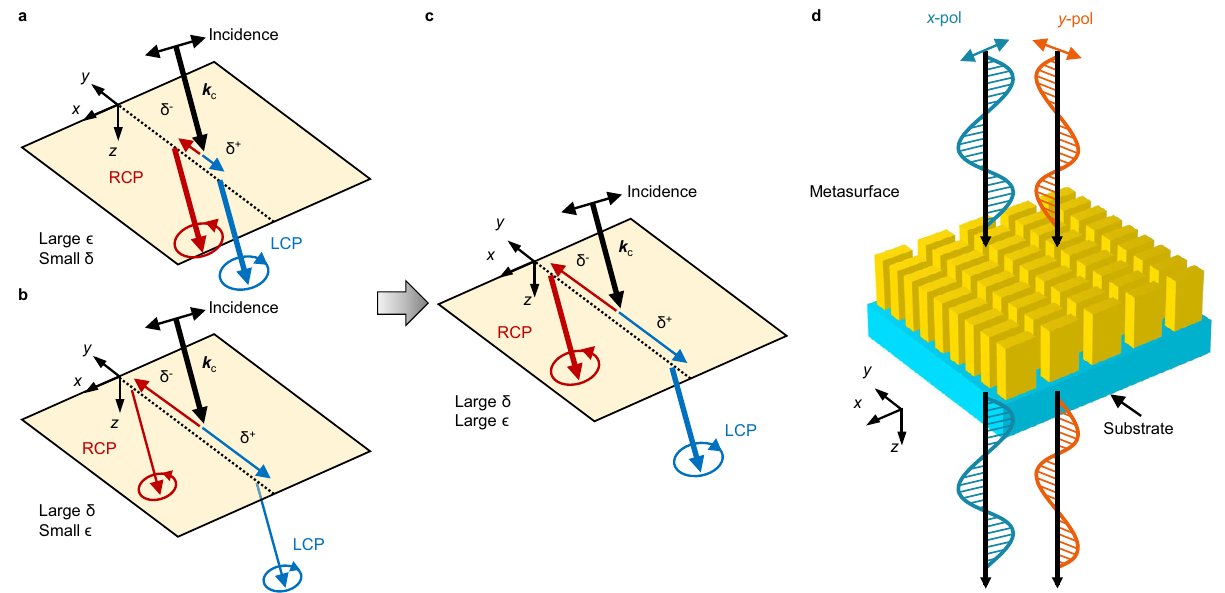
Fig. 1 Schematic of the spin Hall effect of light (SHEL) and a dielectric metasurface to enhance the shift δ and ef fi ciency ϵ of the SHEL simultaneously. a , b Illustration of the SHEL in previous demonstrations. The width of the transmitted beams denotes their intensities. a The ef fi cient SHEL is limited by the small shift, b whereas the enhancement of the shift entails a low ef fi ciency. c Large SHEL with high ef fi ciency. d A metasurface that transmits x - and y - polarized incidence with unity amplitudes ( ∣ t x ∣ = ∣ t y ∣ = 1) but with the opposite phase (arg( t x ) − arg( t y ) = ± π